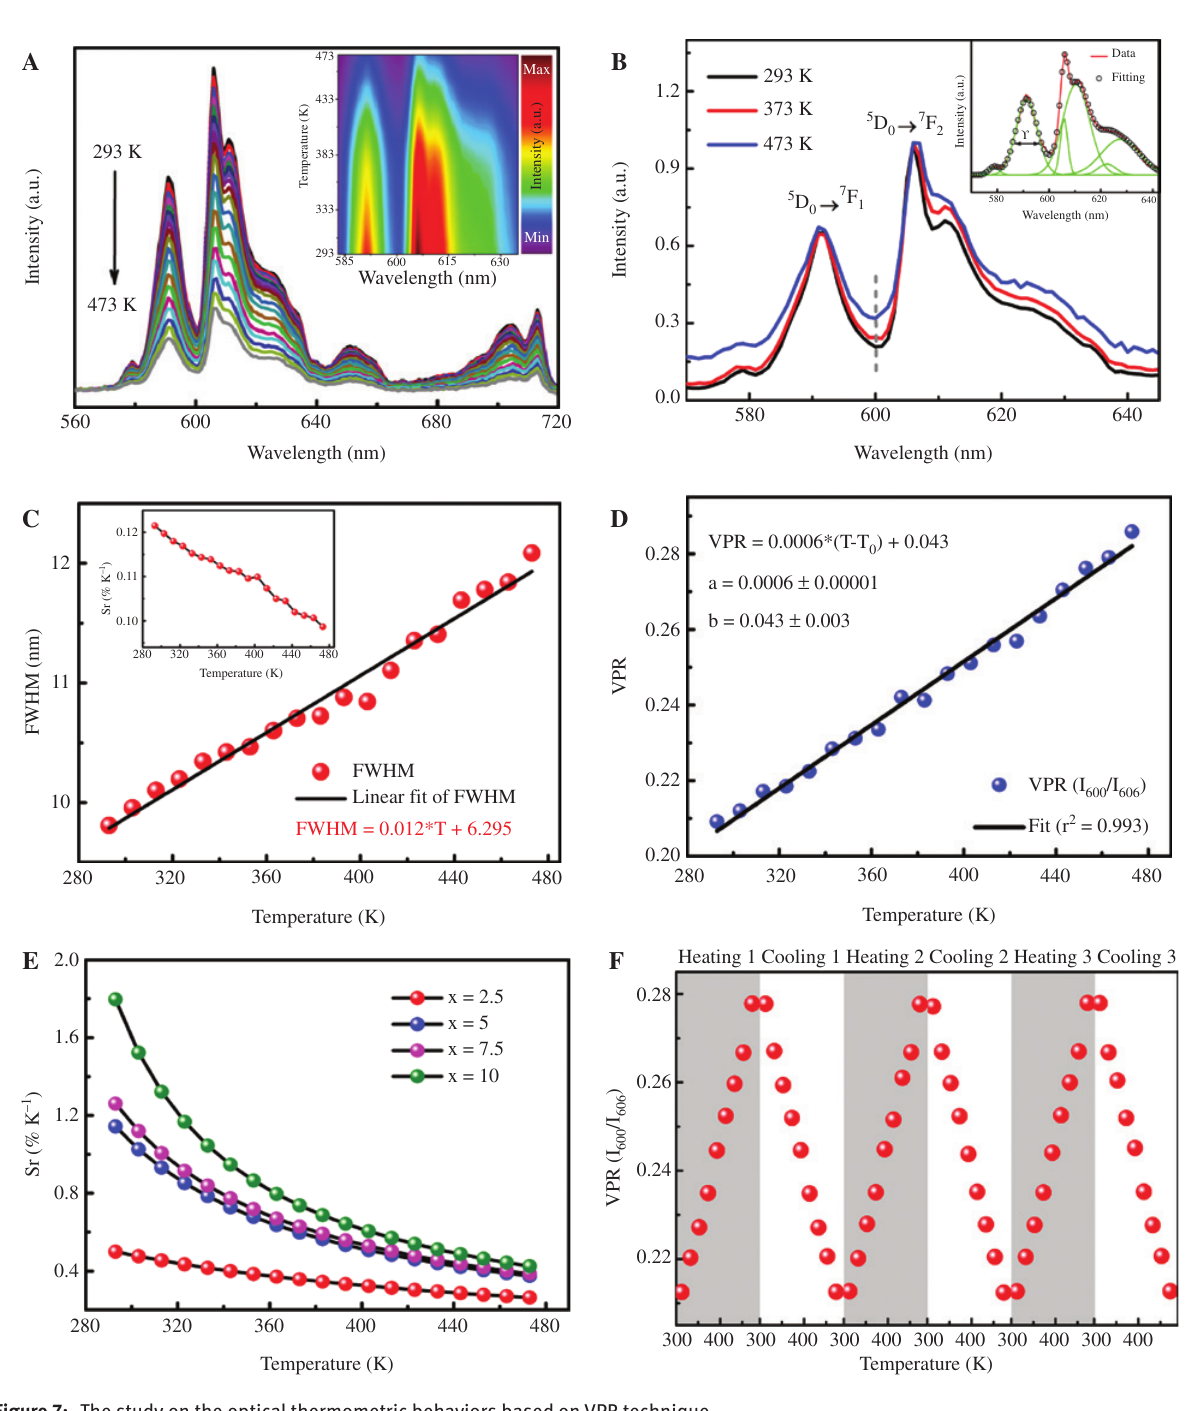
Figure 7: The study on the optical thermometric behaviors based on VPR technique. (A) PL spectra of ZrO :10%Eu 3 + nanocrystals at different temperatures excited at 361 nm. The inset shows the corresponding 2D color- 2 filled contour of temperature-dependent PL spectra. (B) Normalized emission spectra recorded at 293, 373, and 473 K, respectively, → 7 F where the intensity was normalized at 606 nm. (C) FWHM of the 5 D transition ( γ ) vs. temperature. The inset shows the change of 0 1 S with temperature. (D) Variation of VPR as a function of temperature. (E) Temperature dependence of S for samples with different Eu 3 + r r concentrations. (F) Plots of VPR ( I / I ) vs. temperature measured in three heating and cooling cycles for ZrO :10%Eu 3 + 600 606 2 increases with the temperature at a rate of ~ 0.012 nm homogeneous spectral line broadening, which is similar K −1 . And the corresponding relative temperature sensing to the observation in the Nd:YAG ceramic [48]. The slope of the fitted line is ~ 0.012, which means that the bandwidth sensitivity ( S ) can be calculated, which is defined as r